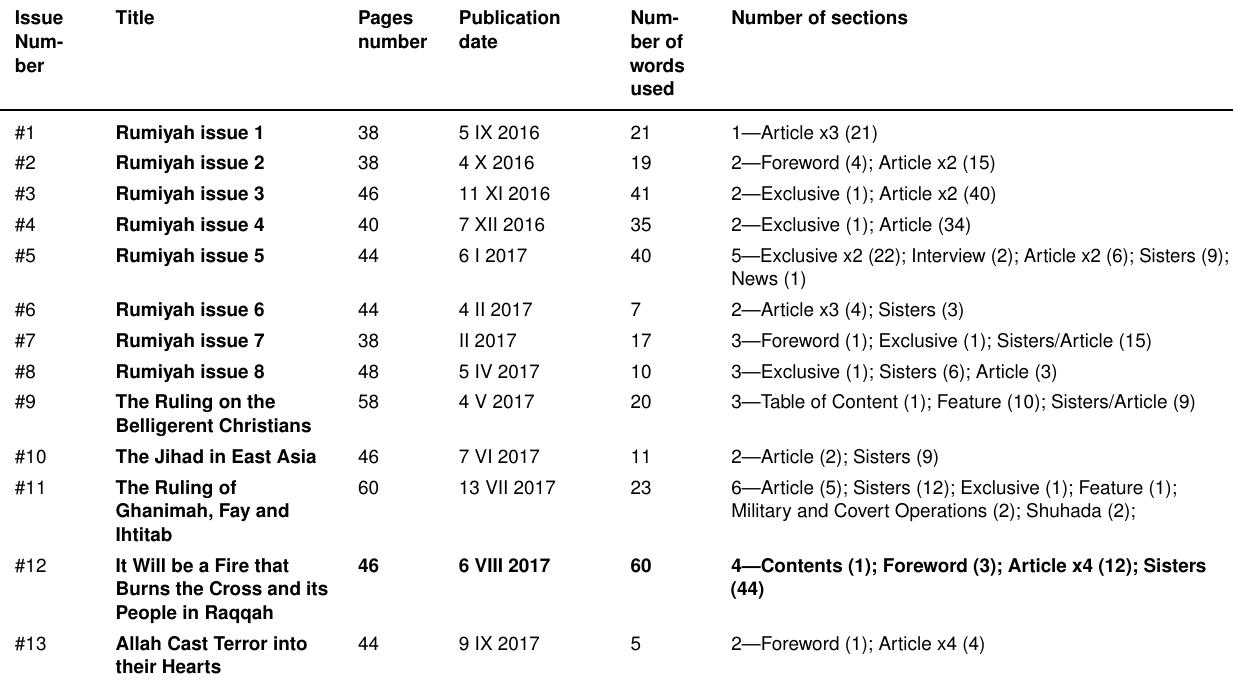
Table 3. The number of words related to women and girls used in the Rumiyah